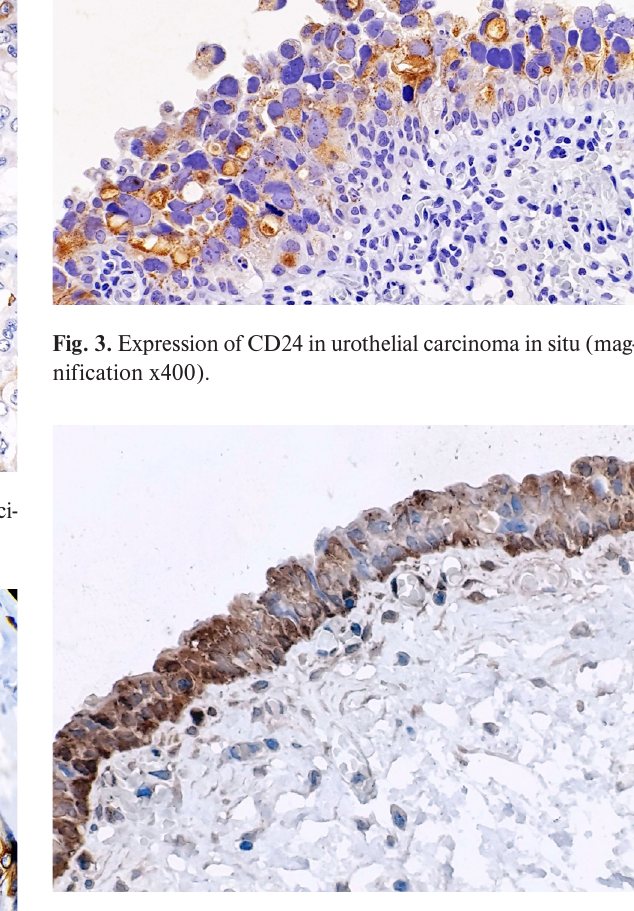
Fig. 4. Expression of CD133 in urothelial carcinoma in situ (magnification